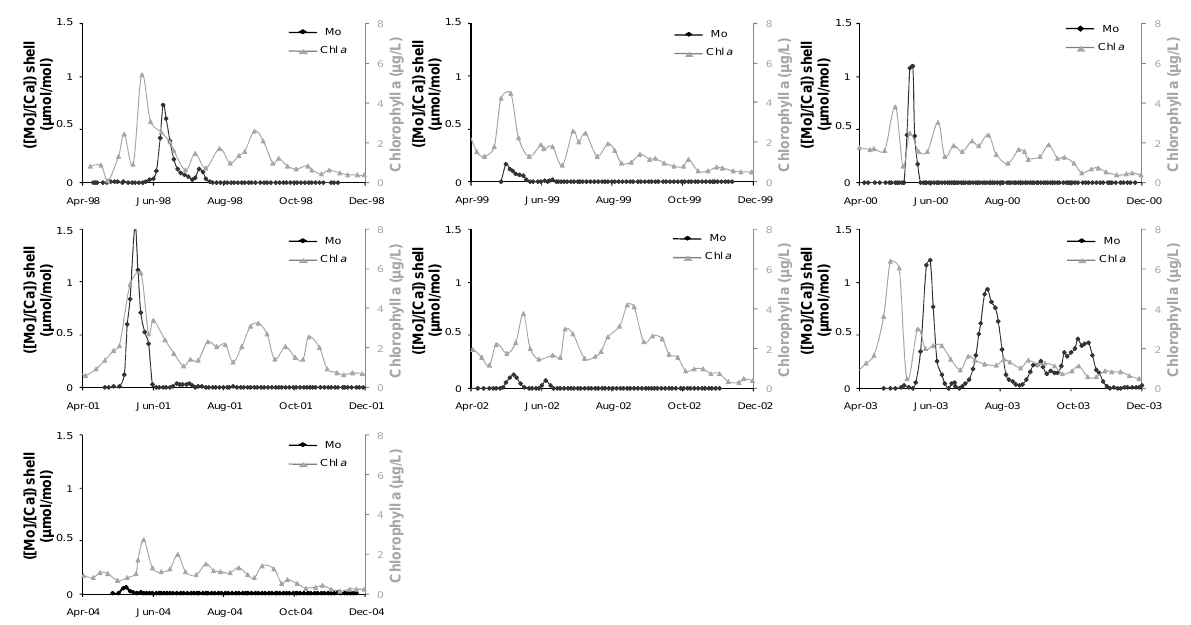
Fig. 3. Mean ([Mo]/[Ca]) shell profiles in shells ( n = 3) from Roscanvel over a 7-year period (1998–2004) compared to chlorophyll a (µg/L) Figure 3. Mean ([Mo]/[Ca]) shell profiles in shells (n=3) from Roscanvel over a 7-year period (1998-2004) compared to chlorophyll a (µg/L) 723 concentrations measured at SOMLIT station in the Bay of Brest (48 ◦ 21 0 N, 4 ◦ 33 0 W), nearby the sampling zone concentrations measured at SOMLIT station in the Bay of Brest (48°21N, 4°33W), nearby the sampling zone (Roscanvel). 724